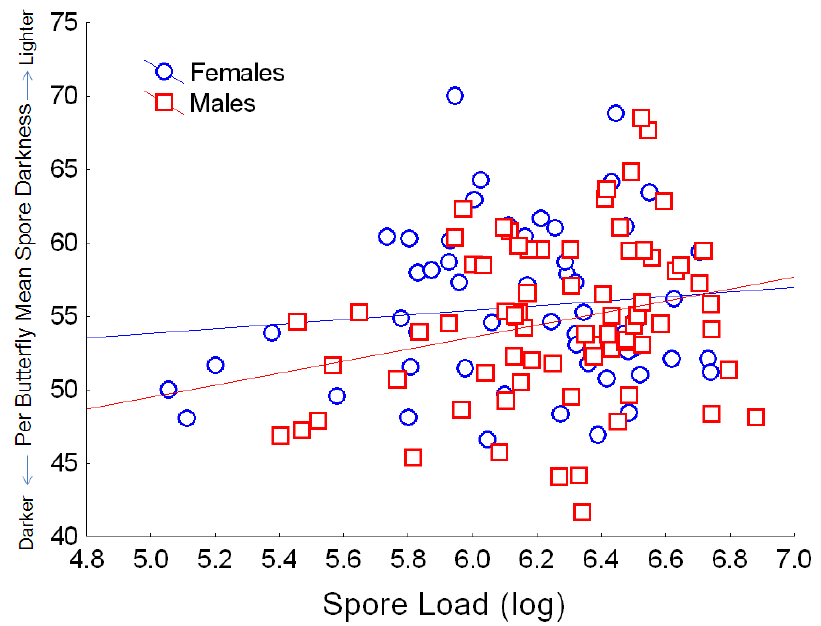
Figure 7. Relationship between the number of spores per butterfly (log average spore darkness (mean per butterfly, based on pixel density, for which the numerical score varies inversely with dark coloration). Simple regression relationship (excluding other predictors from the full model) for females: Y = 46.0 + 1.56X; r 2 = 0.013; for males: Y = 29.07 + 4.09X; r 2 =